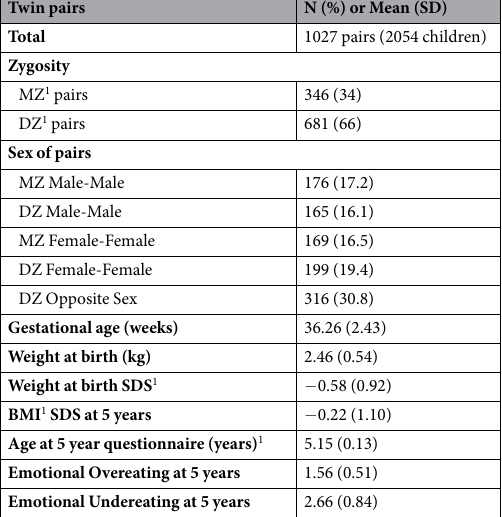
Table 1. Descriptive Statistics for sample included in these analyses. 1 MZ: Monozygotic; DZ: Di-zygotic; SDS: